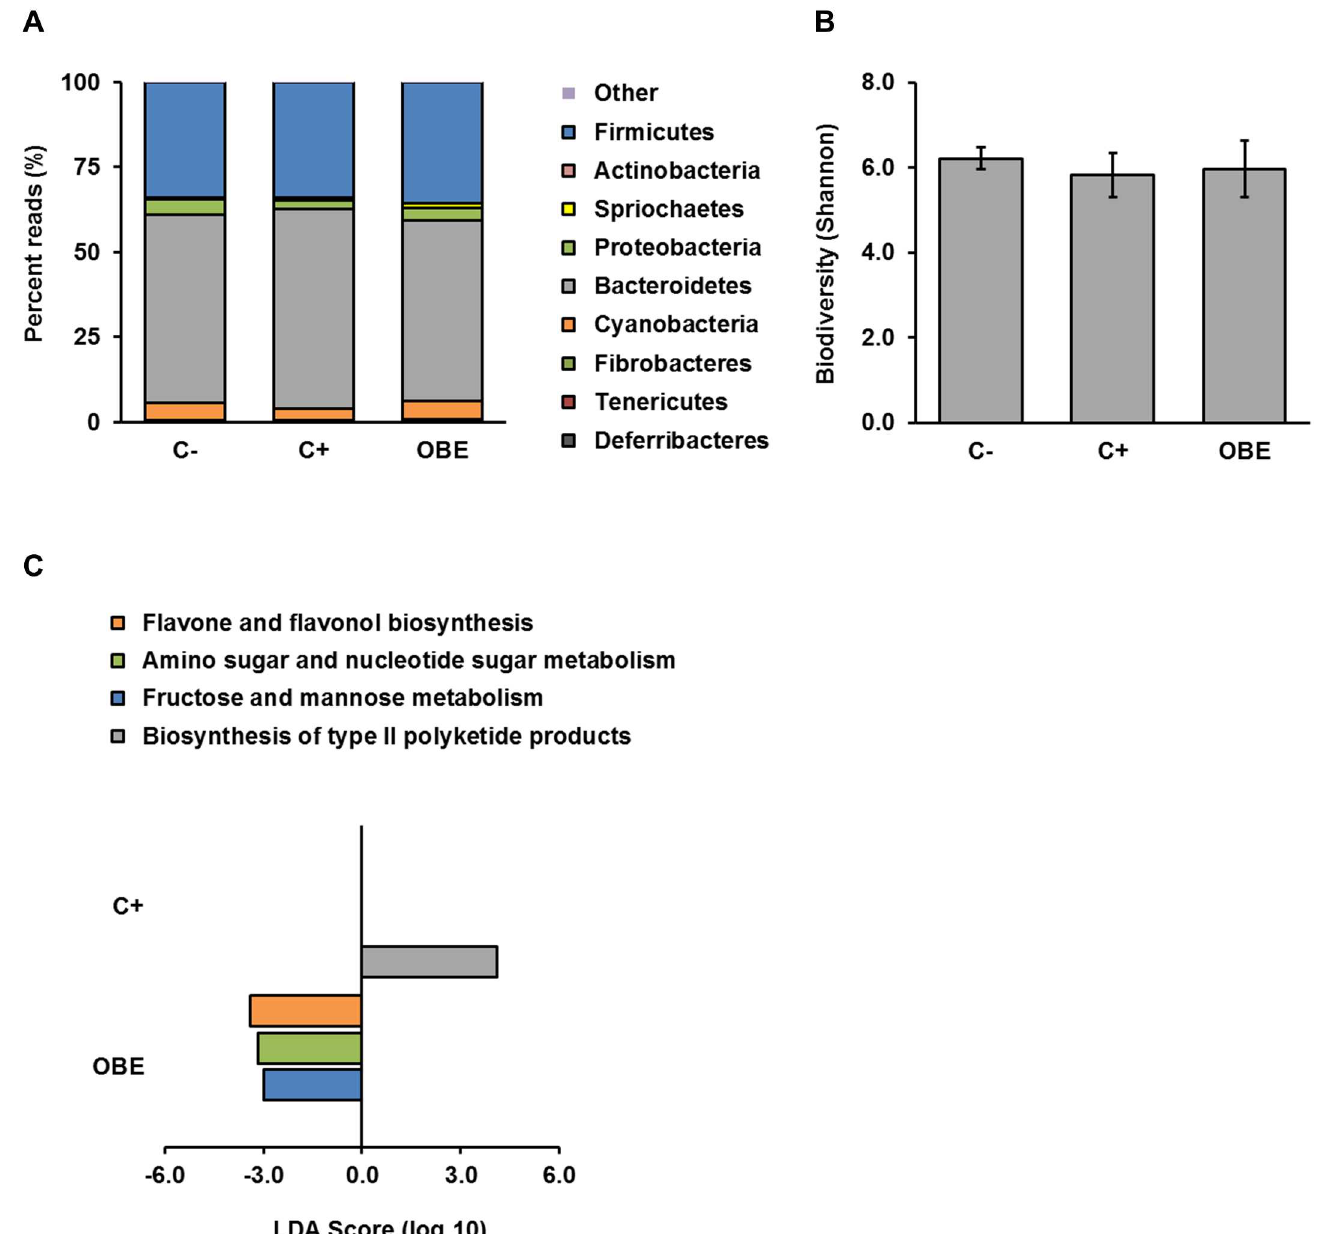
Fig 6. Gut microbial composition and predicted functions in pigs chronically challenged with LPS and fed an Olive-oil Bioactive Extract (OBE). (A) Percent reads at the phylum level in coloniccontents resultingfrom the 16S rRNA gene sequencing analysis. (B) Diversity of colonic microbiota within groups of pigs (alphadiversity; C- vs. C+ p < 0.12, C- vs. OBE p < 1.0, C+ vs. OBE p < 1.0). (C) Lineardiscriminant analysis(LDA) scores for microbialfunctions predicted by PICRUSt ( α = 0.05, LDA score > 3.0). Piglets were fed a standard diet either untreated (C-, C+) or supplemented with an olive-oilextract (OBE; 500 mg/kg diet). On d 20, 23, 26 and 29, OBE and positive control (C+) pigs received E . coli -derived LPS injectionsat increasingdoses (60, 66, 72 and 78 μ g/kg). Negativecontrol animals (C-) were injected with saline.Samples of coloniccontent were collected 3 h after final LPS administration and analyzed via massive sequencing of the V1-V2 hypervariable regions of the 16S rRNA gene(n = 9–11).